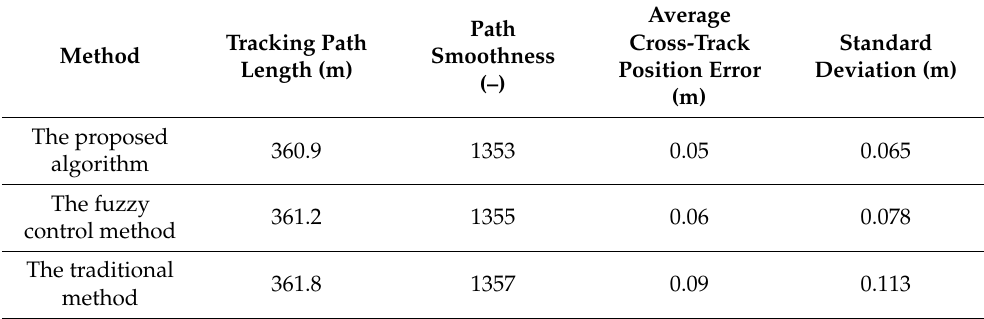
Figure 19. Cross-track heading angle error for the Archimedean spiral. Table 2. Comparison of the proposed and existing algorithms.